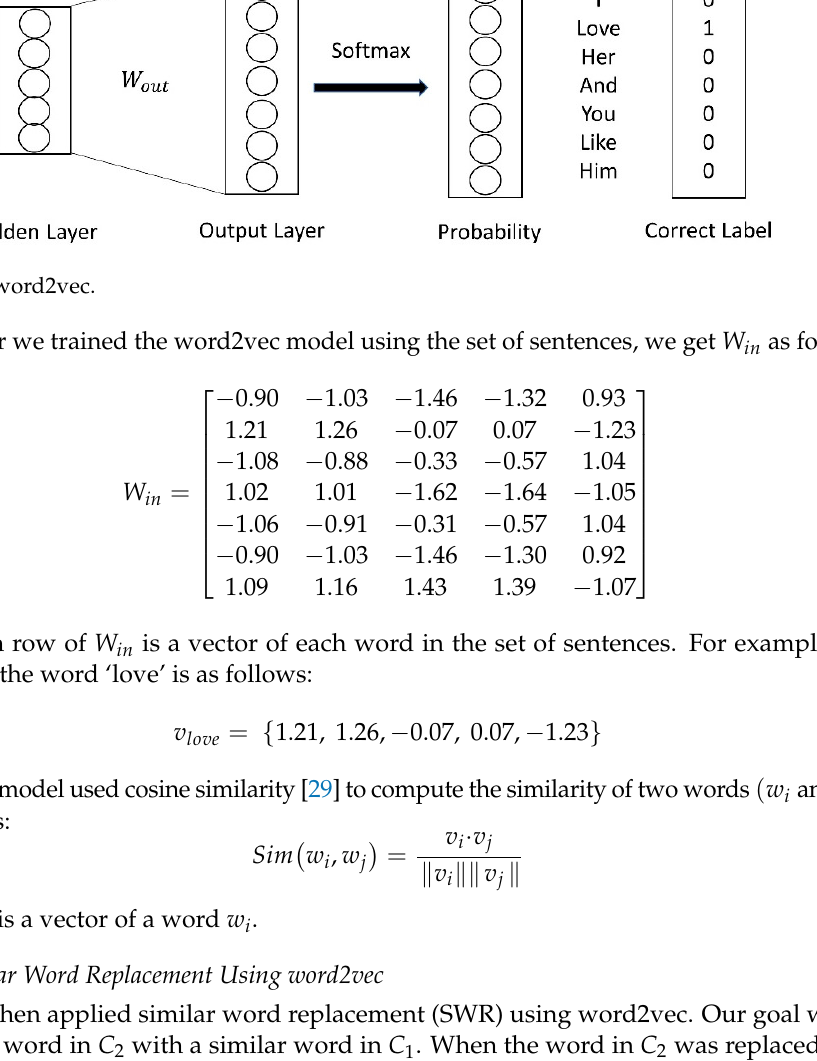
Algorithm 1. Similar Word Replacement using word2vec